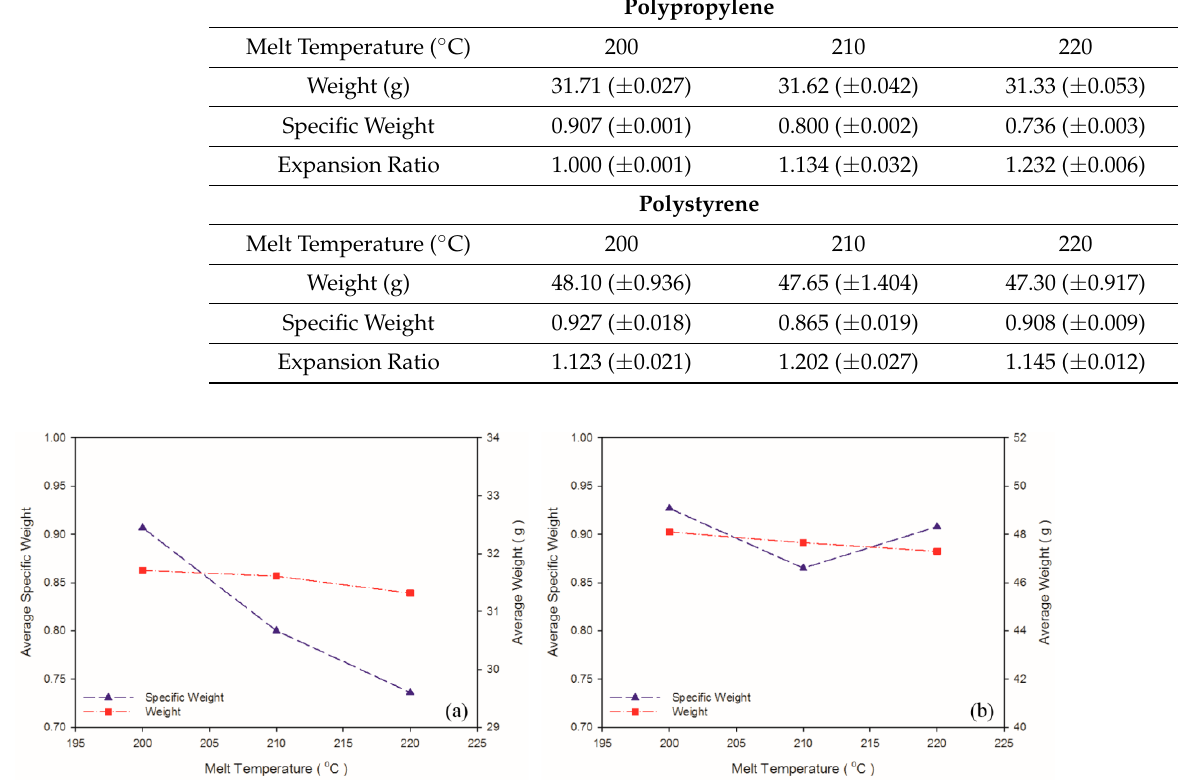
Table 6. Macroscopic effects of melt temperature on weight, specific weight, and expansion ratio.